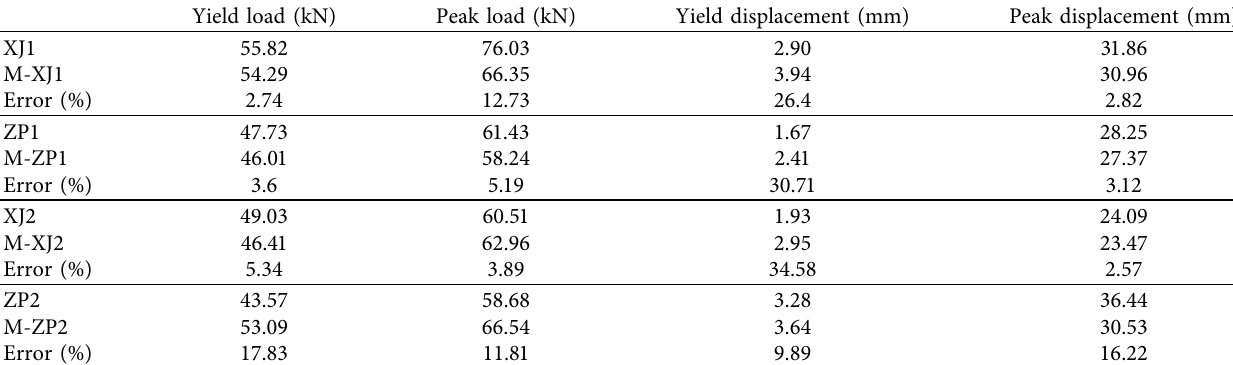
Table 4: Comparison of experimental and numerical simulation